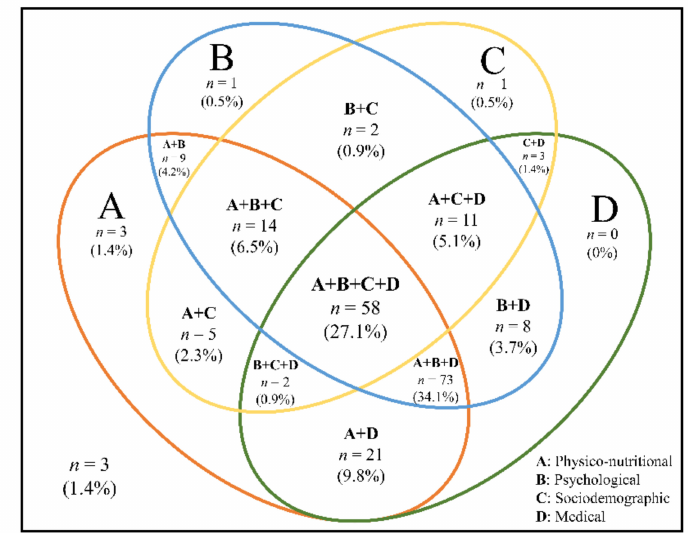
Figure 2. Venn diagram displaying the extent of overlap of risk domains in the frail group (unstandardized sample). A total of 214 adults aged 70–84 years were frail. The physiconutritional domain was defined as having ≥ 1 risk of malnutrition, sarcopenia, severe mobility limitation, longer Timed Up and Go ( > 12 s), and low Short Physical Performance Battery ( ≤ 9 scores). The psychological domain was defined as having ≥ 1 depressive symptom and poor self-perceived health. The sociodemographic domain was defined as having ≥ 1 of rural residence and poor social capital. The medical domain was defined as having ≥ 1 of polypharmacy, elevated hs-CRP ( ≥ 3 mg / L), elevated HbA1c ( ≥ 6.5%), and low 25-hydroxyvitamin D ( ≤ 20 ng /